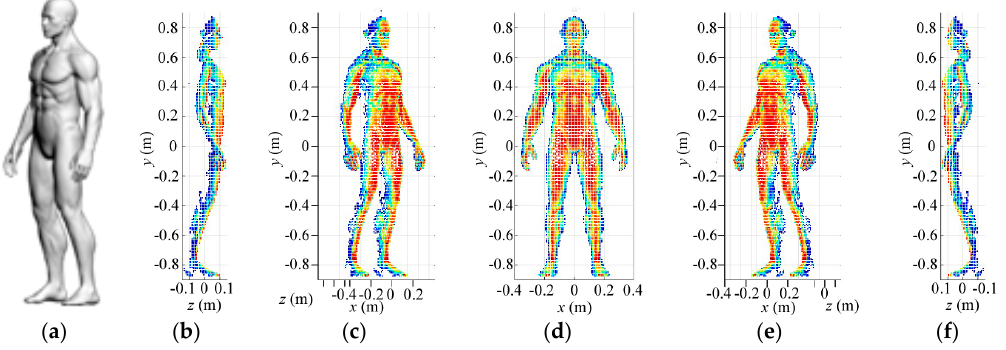
Figure 11. ( a ) The 3D human target, and reconstruction results at low-resolution level in different perspectives: ( b ) the left side; ( c ) the left front side; ( d ) the front; ( e ) the right front side; and ( f ) the right side.